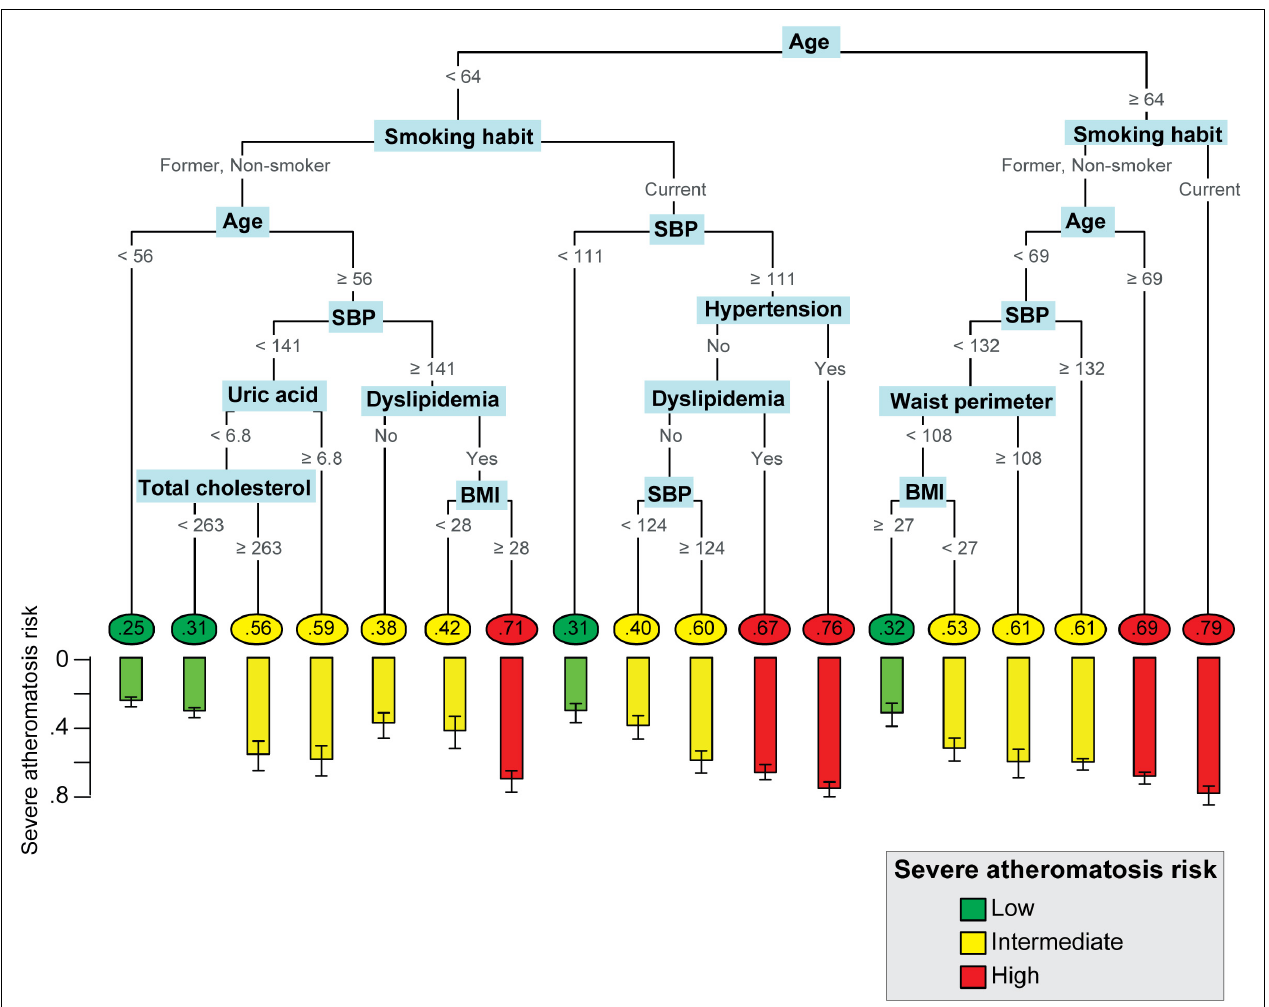
FIGURE 3 | Personalized Algorithm for Severe Atheromatosis Prediction in women. The probability of severe atheromatosis, which corresponds to the proportion of affected patients, was shown inside circles in the final nodes. The barplot offers a clearer visualization of this prevalence with its 95% confidence interval. The colors green, yellow, and red indicate the level of risk (low, intermediate, or high, respectively) identified after calibration. Hypertension and dyslipidemia refer to patients who had prior clinical diagnostic of hypertension or dyslipidemia in their clinical records. The units were as follows: Age: year; BMI: kg/m 2 ; SBP, mmHg; total cholesterol: mg/dL; uric acid: mg/dl; waist perimeter: cm. BMI, body mass index; SBP, systolic blood